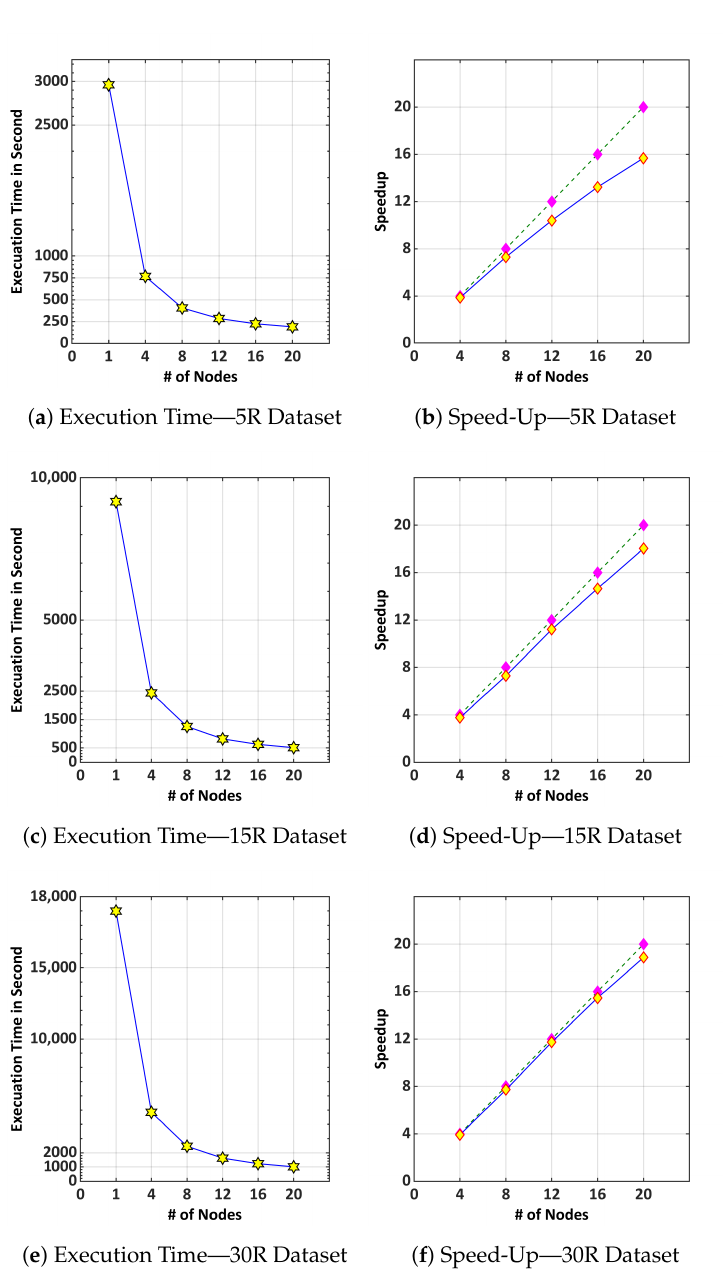
Figure 5. The running time and Speedup results achieved by ABCCS for 5R, 10R, and 30R